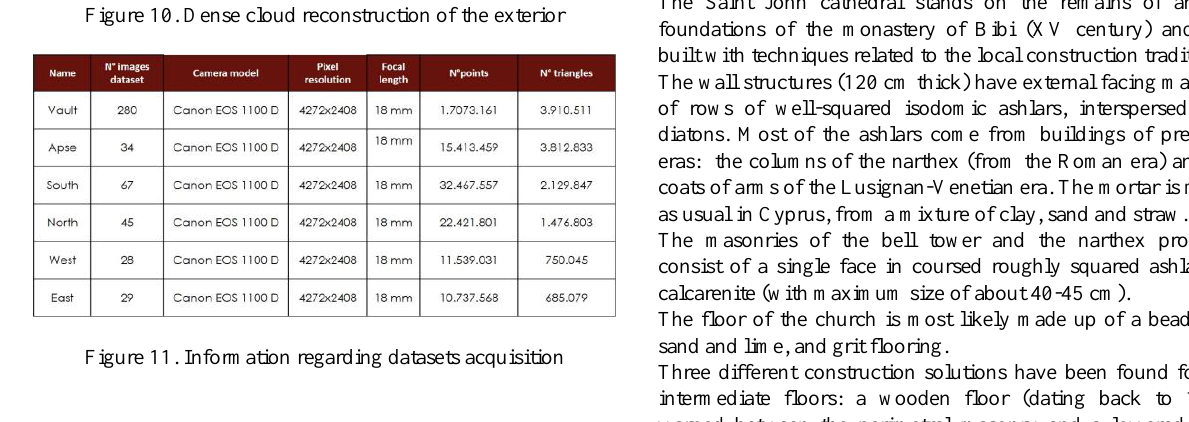
Figure 10. Dense cloud reconstruction of the exterior